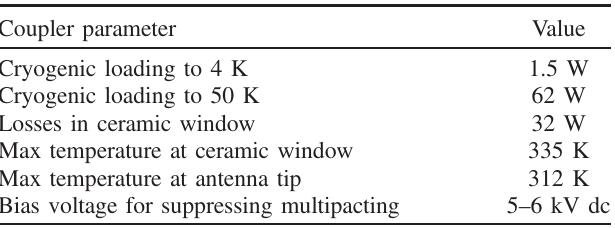
TABLE VI. Summary of the 650 MHz power coupler design parameters at 500 kW forward power.